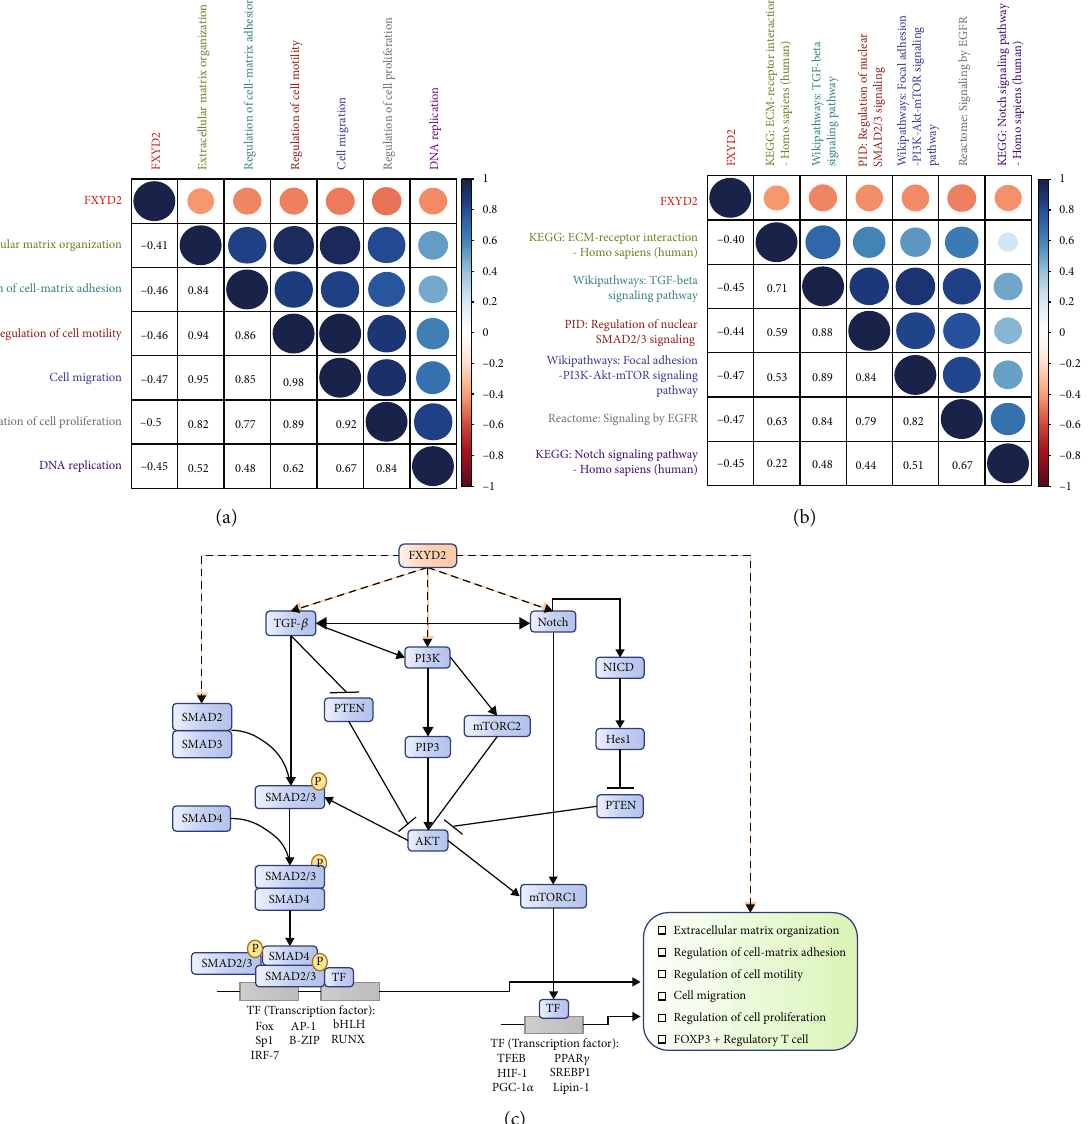
Figure 6: Pearson correlation analysis of FXYD2 expression and biological functions in the TCGA cohort. (a) FXYD2 expression negatively correlated with the biological functions of GO analysis in the TCGA cohort. (b) FXYD2 expression negatively correlated with the signaling pathways of KEGG analysis in the TCGA cohort. (c) Downregulated FXYD2 probably interfered with TGF- β -PI3K-Akt-mTOR/SMAD2/3 signaling pathway in